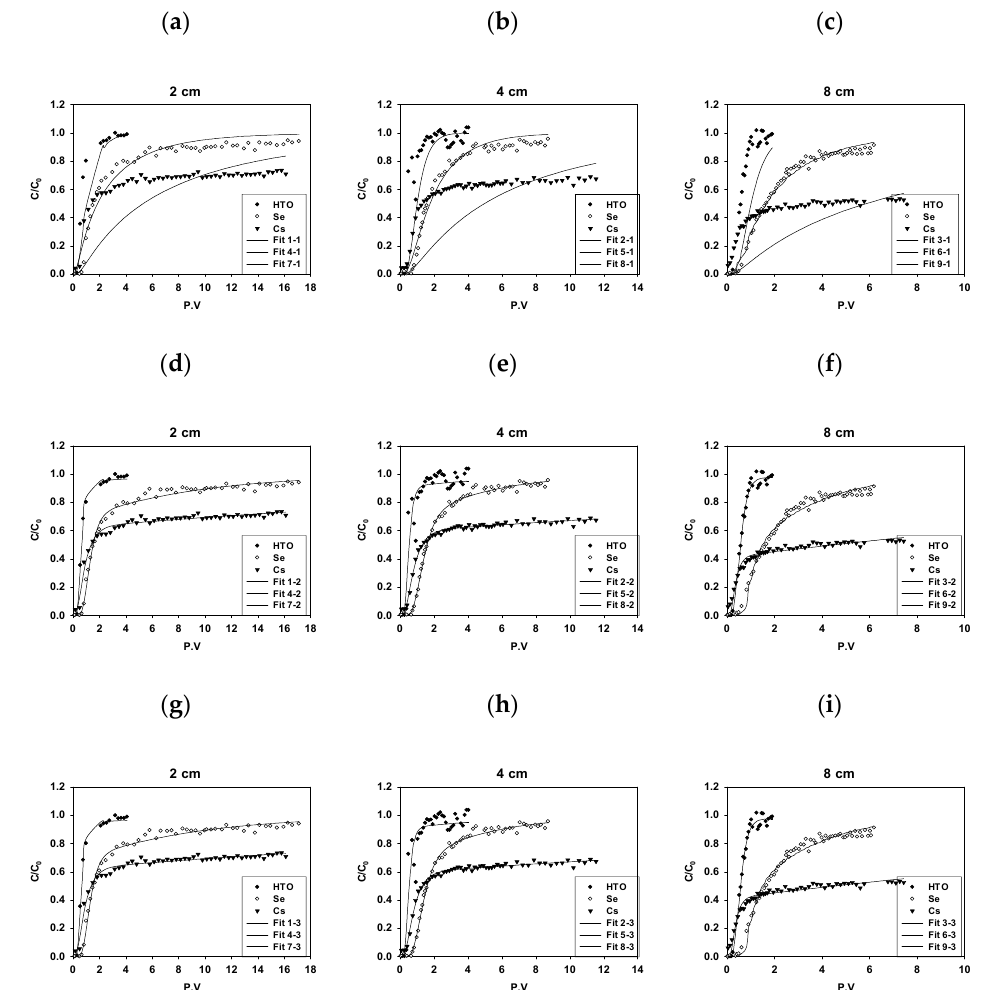
Figure 4. The experimental breakthroughs and curve-fittings for HTO, Se(IV), and Cs. ( a ) 2 cm-equilibrium model; ( b ) 4 cm-equilibrium model; ( c ) 8 cm-equilibrium model; ( d ) 2 cm-physical non-equilibrium model; ( e ) 4 cm-physical non-equilibrium model; ( f ) 8 cm-physical non-equilibrium model; ( g ) 2 cm-chemical non-equilibrium model; ( h ) 4 cm-chemical non-equilibrium model; ( i ) 8 cm-chemical non-equilibrium model. Table 2. The fitting parameters for HTO, Se(IV), and Cs using the equilibrium model. RN No. RMSE Fit 1-1 HTO